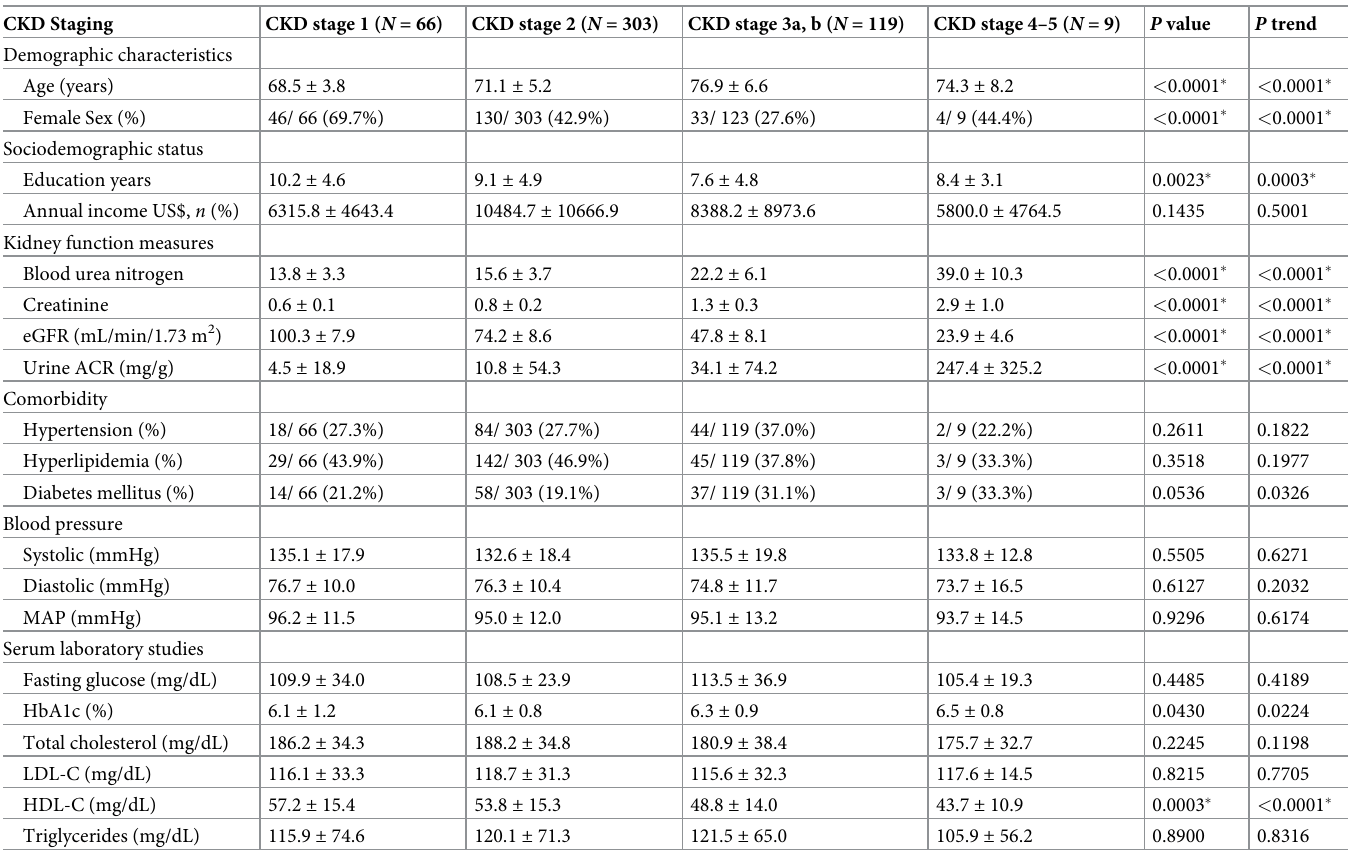
Table 1. Renal function and mental function health status ( N =